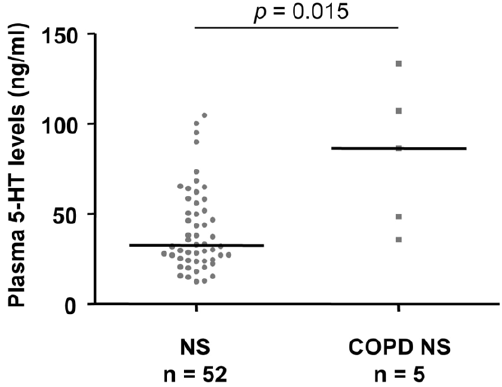
Figure 3. Preliminary findings on the plasma 5-HT levels of COPD non-smokers and control subjects. Plasma 5-HT levels of healthy non-smokers (NS) and COPD non-smokers (COPD NS). Solid horizontal line represents the median value. P values were obtained from the Mann-Whitney U test.